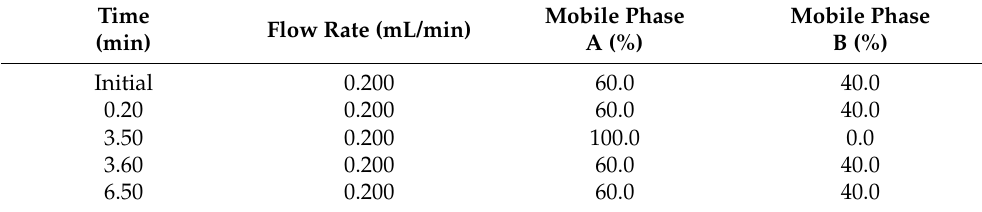
Table 2. Parameters of the mobile phase in the liquid chromatography